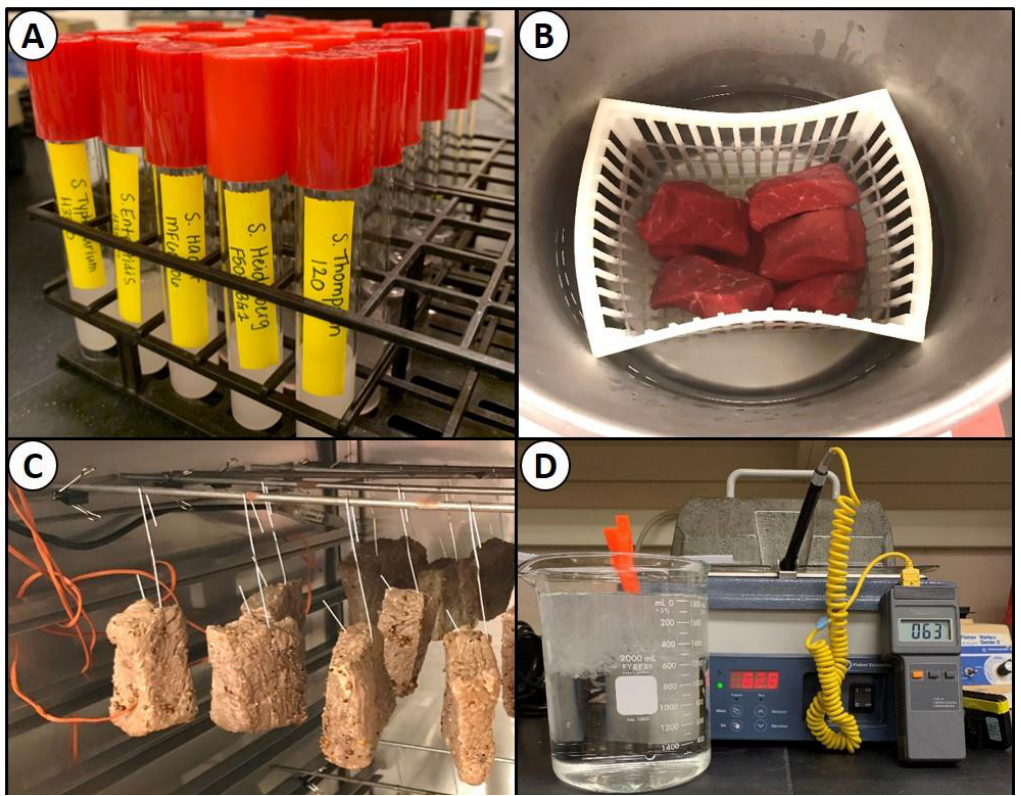
Figure 1. Stress conditions for Salmonella serovars: ( A ) nutrient depletion/starvation by extended refrigeration of individual Salmonella serovars in 0.1% BPW; ( B ) acid stress by dip treatment of Salmonella -inoculated beef in acidic solutions (vinegar, 5%; 3% sodium acid sulfate; 5% lactic acid); ( C ) desiccation of Salmonella -inoculated and spice-coated beef at 23.9 °C (75 °F) and 55% RH in a temperature-controlled humidity oven; ( D ) thermal heating of vacuum-packaged bags containing Salmonella inocula at 62.8 °C (145 °F) for 75 sec.